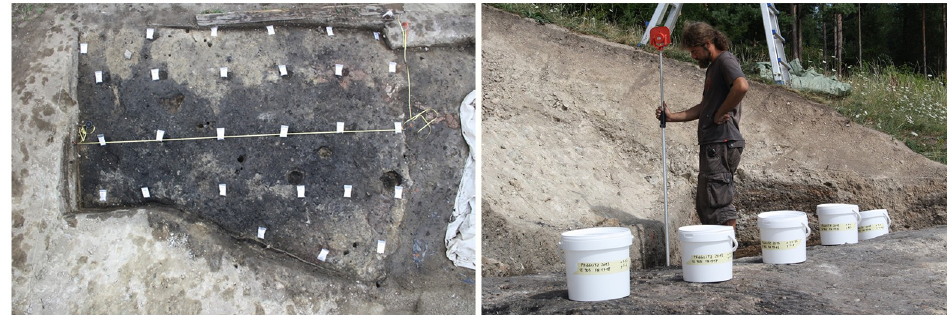
Fig 7. Systematic sampling for botanical remains and micro-refuse by M. Konrad. Images: UIBK/P. Trebsche.